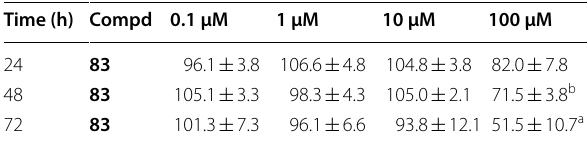
Table 17 Tricyclic compound-induced inhibition of HCT116